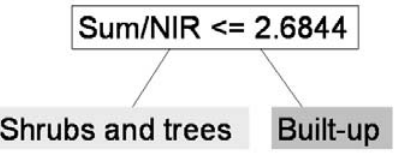
Figure 10. Result of the classification tree analysis used for classification of the CIR orthoimages where the nDSM initially had been applied for classification of ground objects (height < 0.5